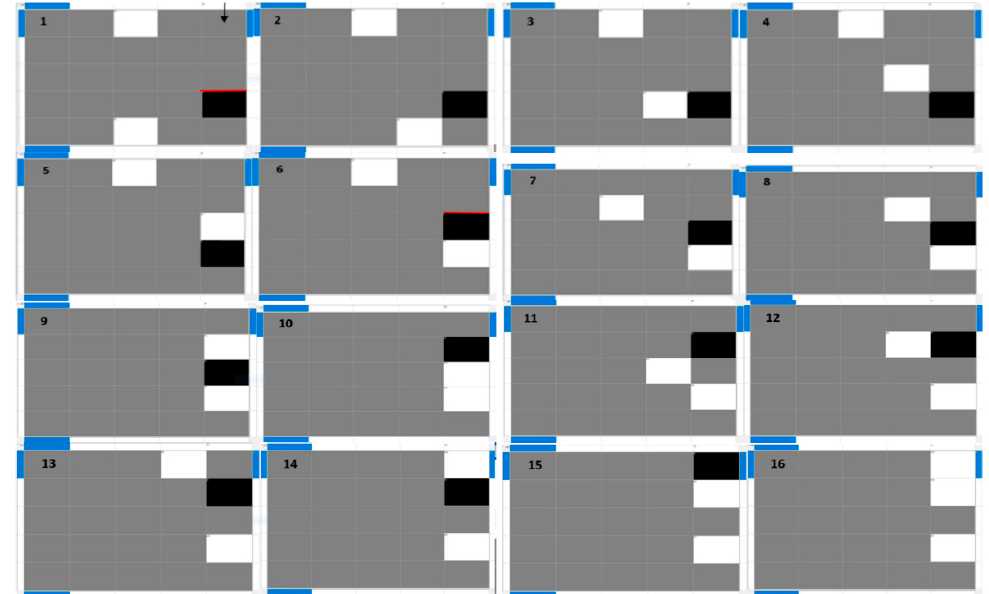
Figure 10. Example 1.